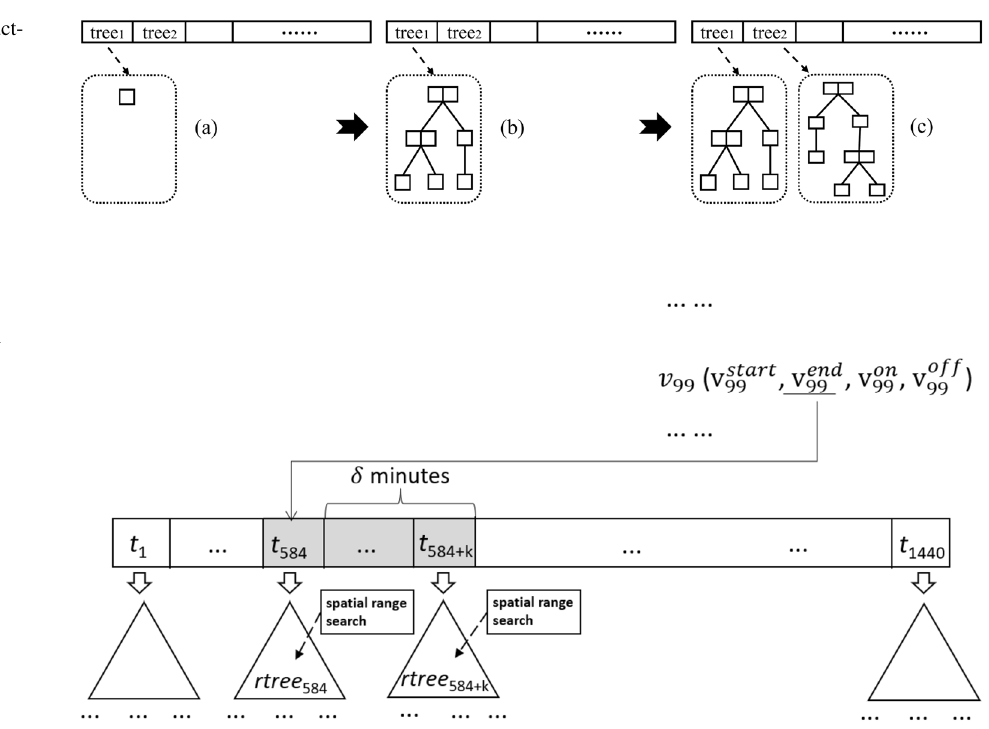
Fig. 6 The process of construct- ing a trip index